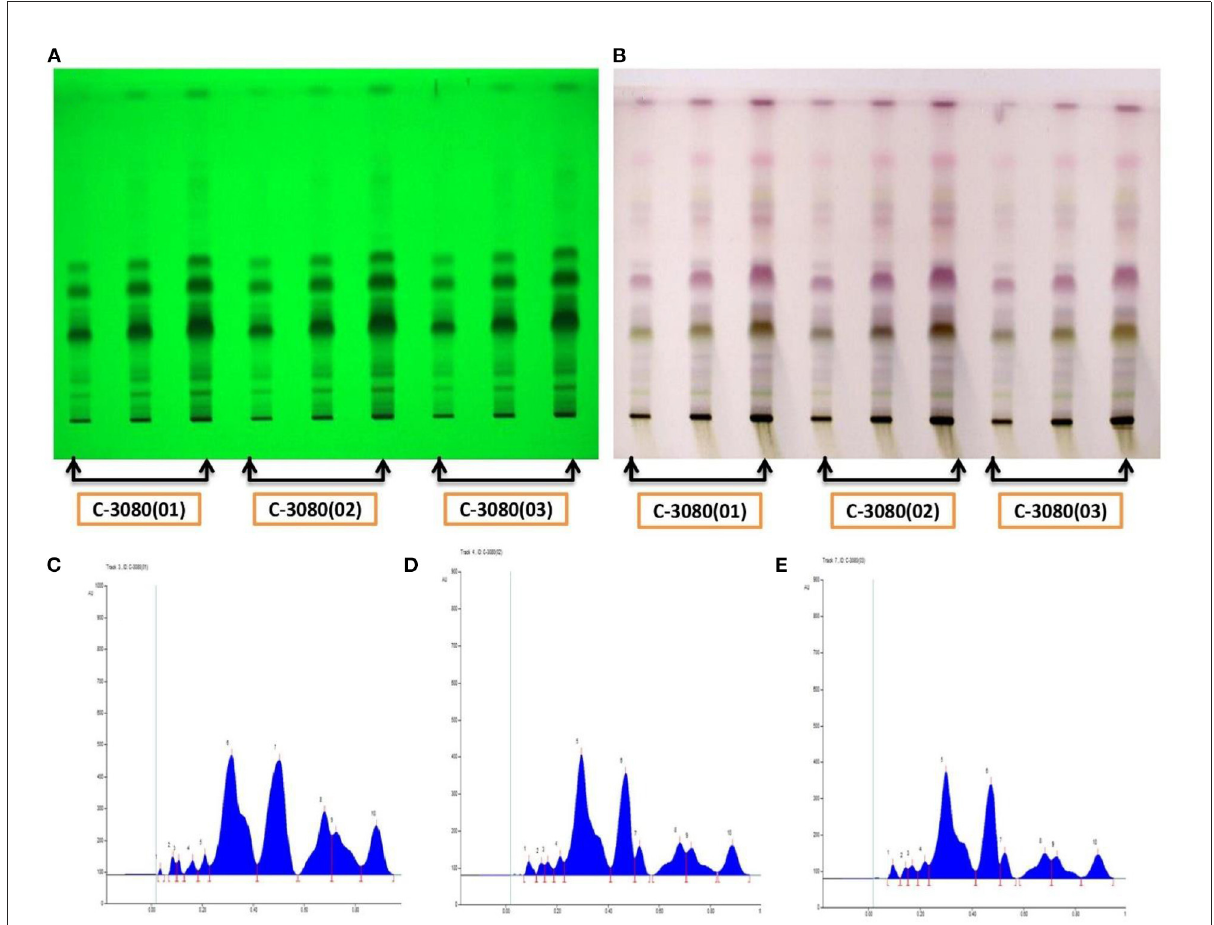
FIGURE9 Fingerprinting and monographs of three batches of TC : Batch A [C-3080(01)], Batch B [C-3080(02)], Batch C [C-3080(03)], and by derivatization Reagent. (A) Fingerprinting of three batches of TC by using mobile phase Toluene: Ethyl acetate: Acetic acid (8:2:0.1) @ 254nm, (B) Fingerprinting of three batches of TC by using derivatization reagent anisaldehyde sulphuric acid reagent @ 500nm, (C) Peaks of batch A, (D) Peaks of batch B, (E) Peaks of batches